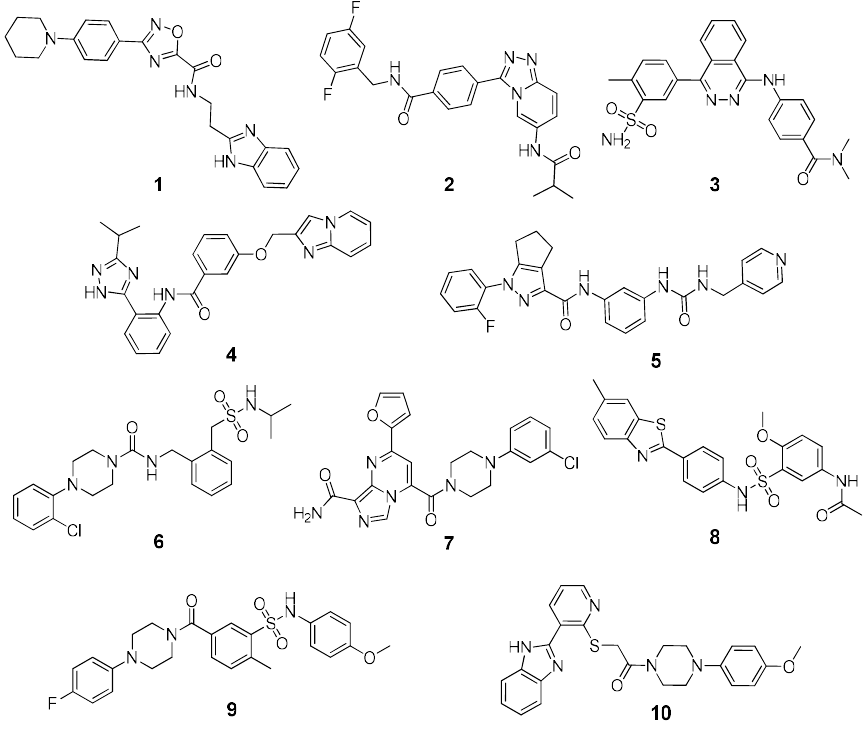
Figure 3. Structure of the 10 ligands selected through the VS study (compounds 1 – 10 ) performed by Banoglu and co-workers.